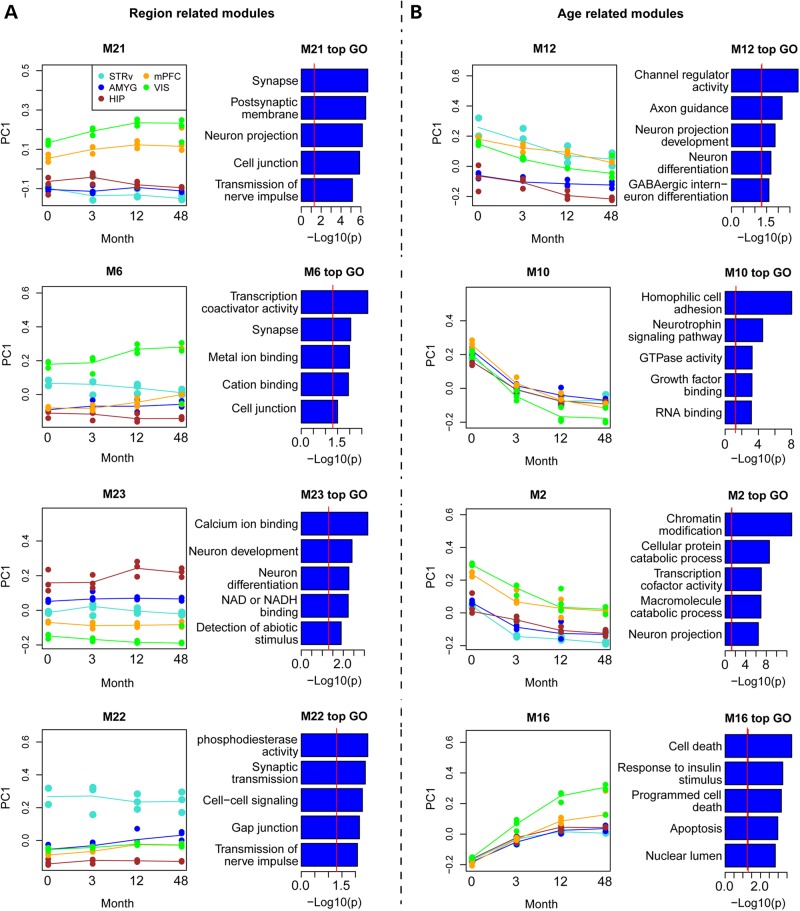
Expression patterns of modules associated with ages and regions. Line plot for four modules related to region (A) and four related to age (B). The left plots show the developmental profiles of each module, plotted separately for each brain region (using different colors). X-axes show the developmental stages, while y-axes show the value of eigengene (PC1) for each module. Adjacent plots show the top 5 GO pathways associated with each module, with some redundant categories filtered. Bars show the significance of each category. Vertical red lines indicate nominal P = 0.05.